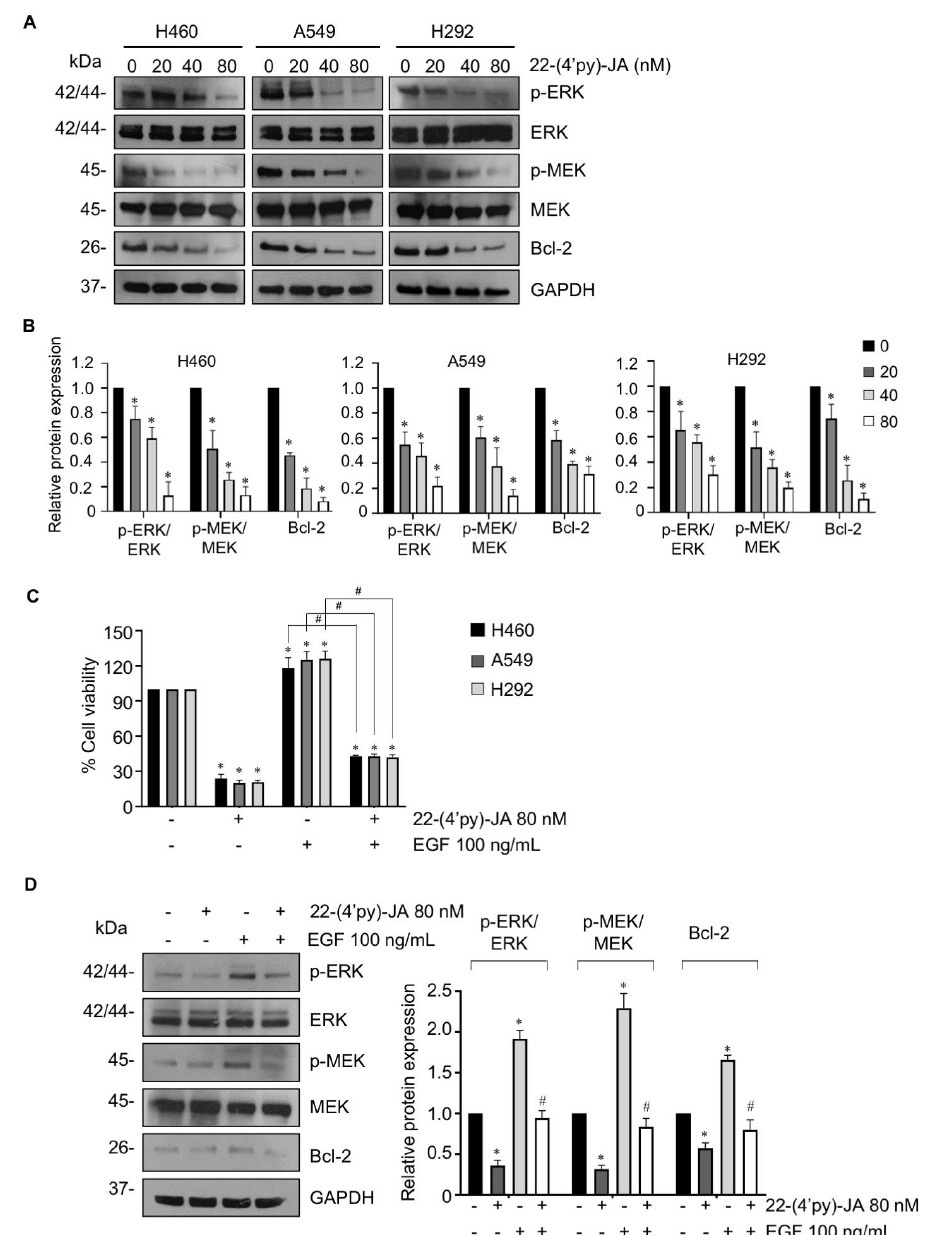
Figure 9. The effect of 22-(4 (cid:48) py)-JA on MEK/ERK/Bcl-2 expressions. ( A ) H460, A549 and H292 cells were incubated with 22-(4 (cid:48) py)-JA for 24 h. The expression levels of phosphorylated MEK1/2 (p-MEK1/2), MEK1/2, p-ERK1/2, ERK1/2 and Bcl-2 were analyzed by immunoblotting. Blots were reprobed with anti-GAPDH as a loading control. Representative blots from triplicate independent ex- periments are shown. ( B ) Densitometry analysis of protein expression was performed and presented as a relative value to the control group. Data are the mean ± SD ( n = 3). * p < 0.05 vs. untreated control cells. ( C ) H460, A549 and H292 cells were pretreated with epidermal growth factor (EGF) for 1 h, prior to 22-(4 (cid:48) py)-JA (80 nM) for 48 h. Cell viability was examined by MTT assay and represented as a percentage. ( D ) A549 cells were pretreated with epidermal growth factor (EGF) for 1 h, prior to 22-(4 (cid:48) py)-JA (80 nM) for 24 h. The expression levels of phosphorylated MEK1/2 (p-MEK1/2), MEK1/2, p-ERK1/2, ERK1/2 and Bcl-2 were analyzed by immunoblotting. Blots were reprobed with anti-GAPDH as a loading control. Densitometry analysis of protein expression was performed and presented as a relative value to the control group. Data are the mean ± SD (n = 3). * p < 0.05 vs. untreated control cells. # p <0.05 vs. EGF-treated